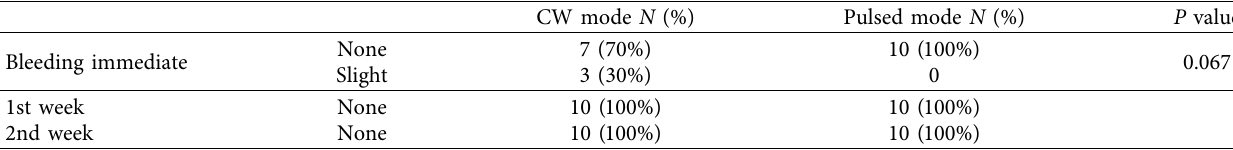
Table 2: Displays the diferences in bleeding availability between CW and pulsed groups using the Mann–Whitney U test with their frequencies ( N ) and percentages